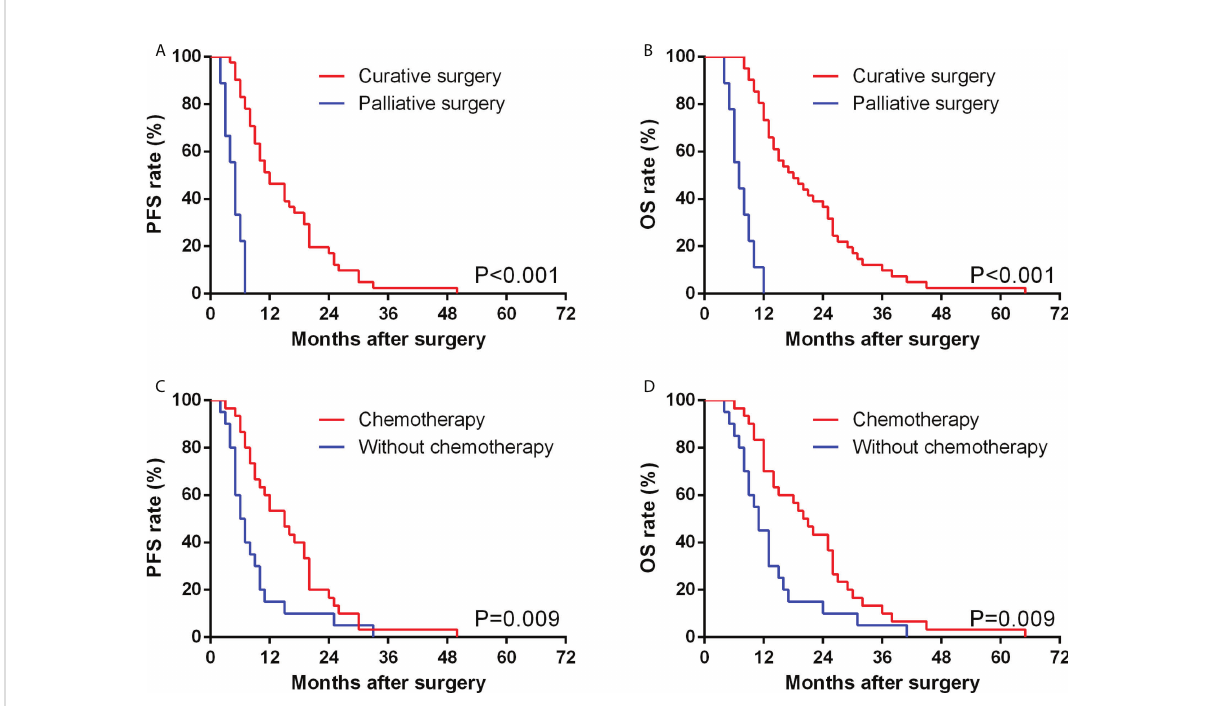
FIGURE 2 Comparison of PFS (A) and OS (B) between GBSC patients who underwent curative surgery and those who underwent palliative surgery by Kaplan − Meier analysis. Comparison of PFS (C) and OS (D) between GBSC patients who received postoperative chemotherapy and those who did not receive postoperative chemotherapy by Kaplan − Meier